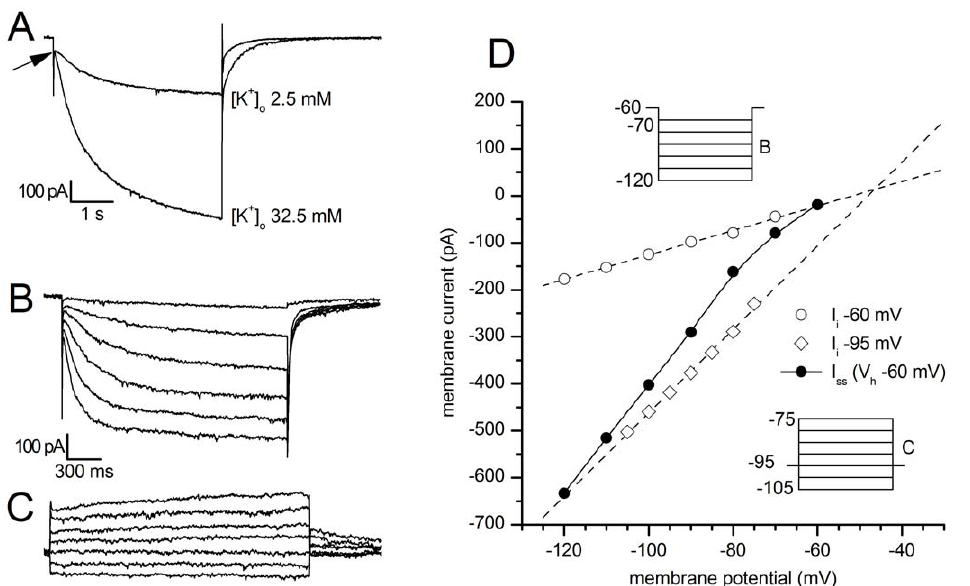
Figure 3. Analysis of Ih reversal potential. A: Response to hyperpolarizing steps from 2 40 to 2 130 mV using the indicated concentration of K + ions in the external saline; T=27 u C. B,C: Recordings of the slow current relaxations recorded at holding potentials of 2 60 and 2 95 mV, respectively, in response to the indicated protocols represented in the insets of Figure D; T=37 u C. D: Instantaneous (chord) and ‘steady-state’ current-voltage relationships of a SNc DA neuron voltage-clamped at holding potentials of 2 60 mV (chord conductance 2.60 nS) and 2 90 mV (chord conductance 8.89 nS). Note that the chord conductance plots are approximately linear at both the holding potentials, despite the presence of strong inward rectification in the ‘steady-state’ current-voltage relationship measured at the end of 2 s hyperpolarizing voltage jumps from a holding potential of 2 60 mV. Inward rectification in the ‘steady-state’ current-voltage relationship is entirely accounted by these slow relaxations.